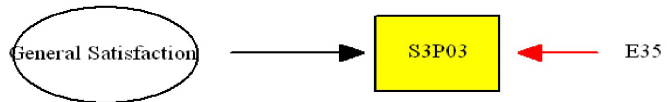
Figure 1a. Satisfaction Models tested. Single-item scale